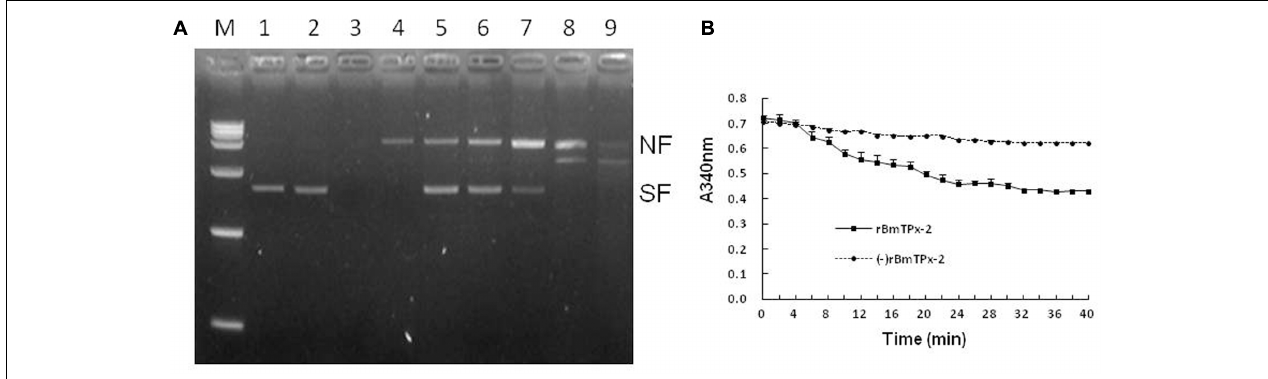
FIGURE 3 | Antioxidant activity of the BmTPx-2 protein. (A) DNA protection experiment analyzed by MFO system. M, DNA marker; (1) DNA+ H 2 O; (2) DNA+ DTT; (3) DNA+ FeCl 3 ; (4) DNA+MFO; (5) 335 µ g/mL rBmTPx-2+MFO+DNA; (6) 167 µ g/mL rBmTPx-2+MFO+DNA; (7) 83 µ g/mL rBmTPx-2+MFO+DNA; (8) 55 µ g/mL rBmTPx-2+MFO+DNA; (9) 42 µ g/mL rBmTPx-2+MFO+DNA. The nicked form (NF) and supercoiled form (SF) of the plasmids are indicated on the right and the triangle shows the increasing concentration of the recombinant proteins. (B) Antioxidant function of identification by using a Trx-TrxR assay system. The solid line indicates the antioxidant function of rBmTPx-2; the dotted line indicates the absence of rBmTPx-2. NADPH oxidation was monitored as the decrease in (A) 340 nm. The Data are presented as the means of three independent experiments.